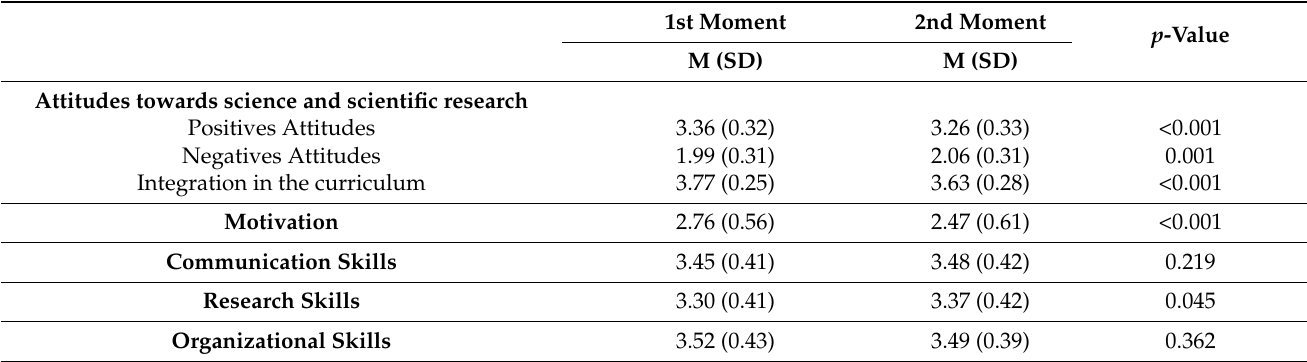
Table 2. Comparison between medical students’ attitudes and perceptions towards science and scientific research in both moments of data